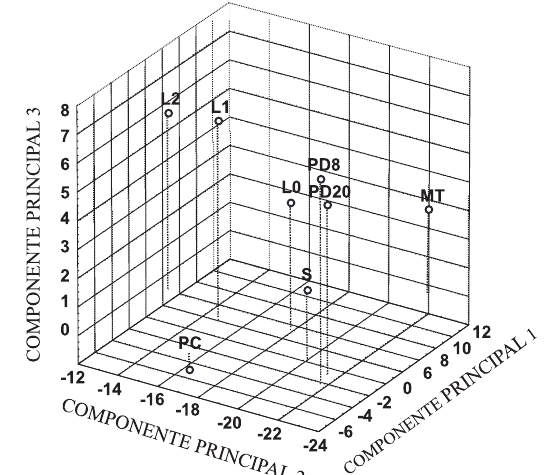
Figura 1. Projeção dos componentes principais 1, 2 e 3 (com respectivamente 44, 25 e 13 % da variação explicada) retidos na análise das